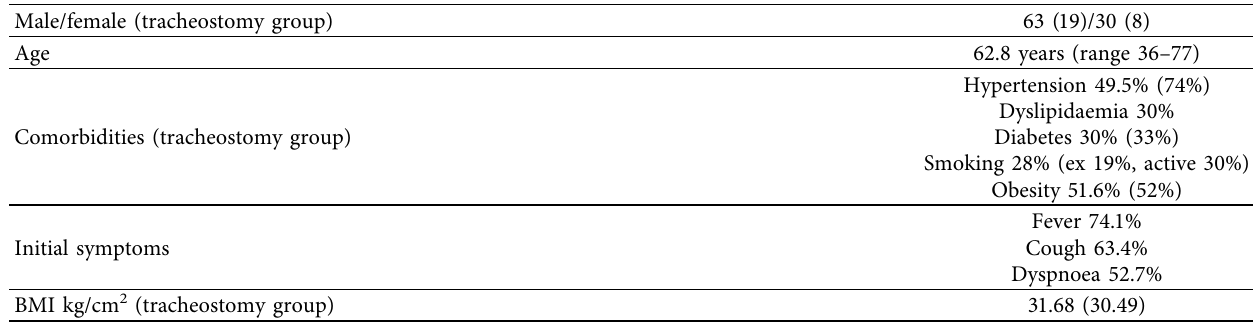
Table 1: Clinical characteristics of COVID-19